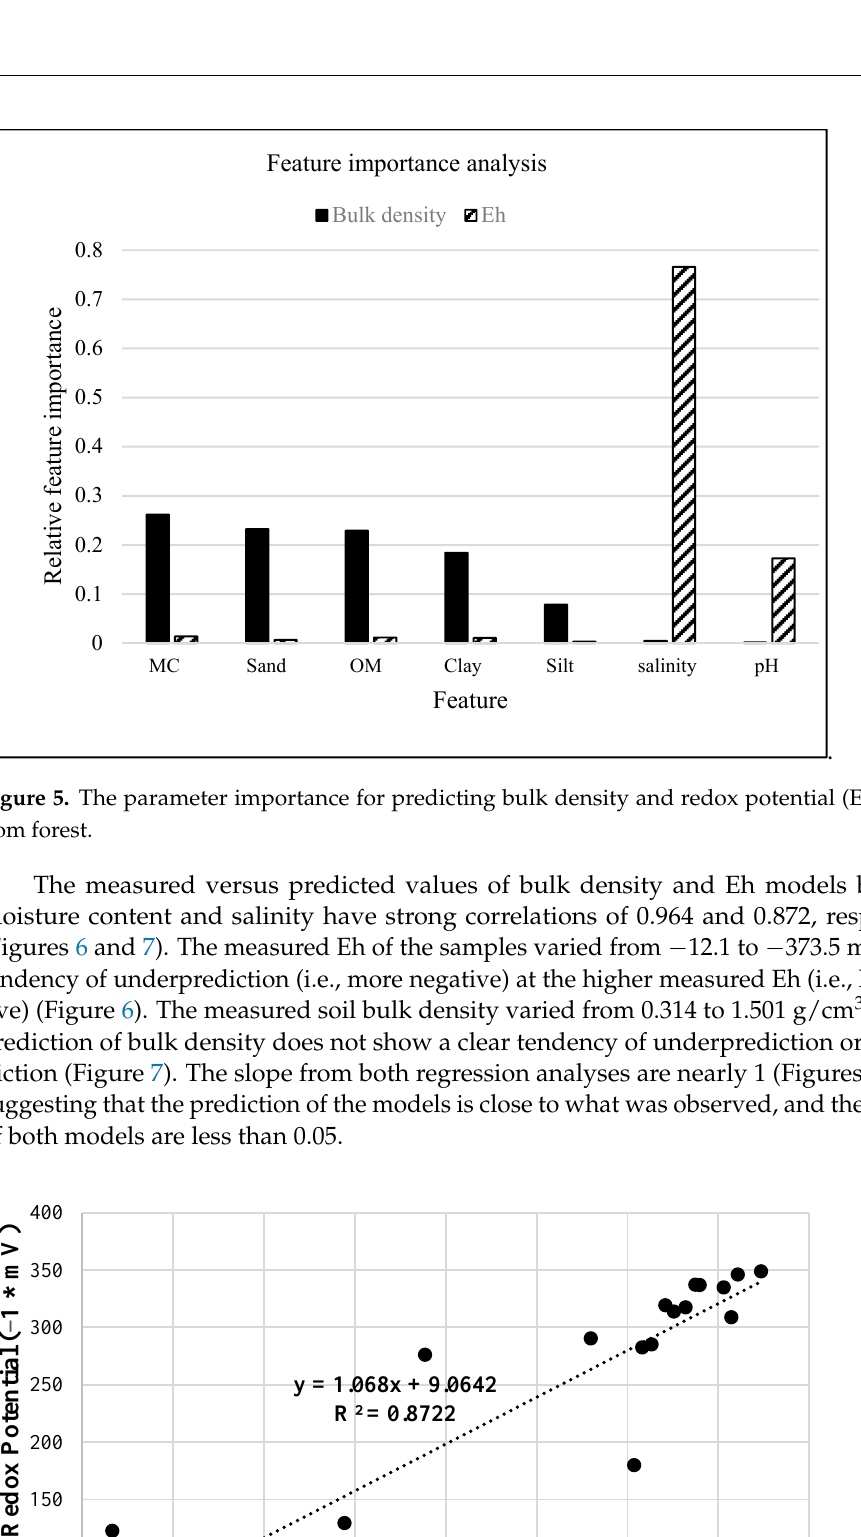
y = 1.068x + 9.0642 R² = 0.8722